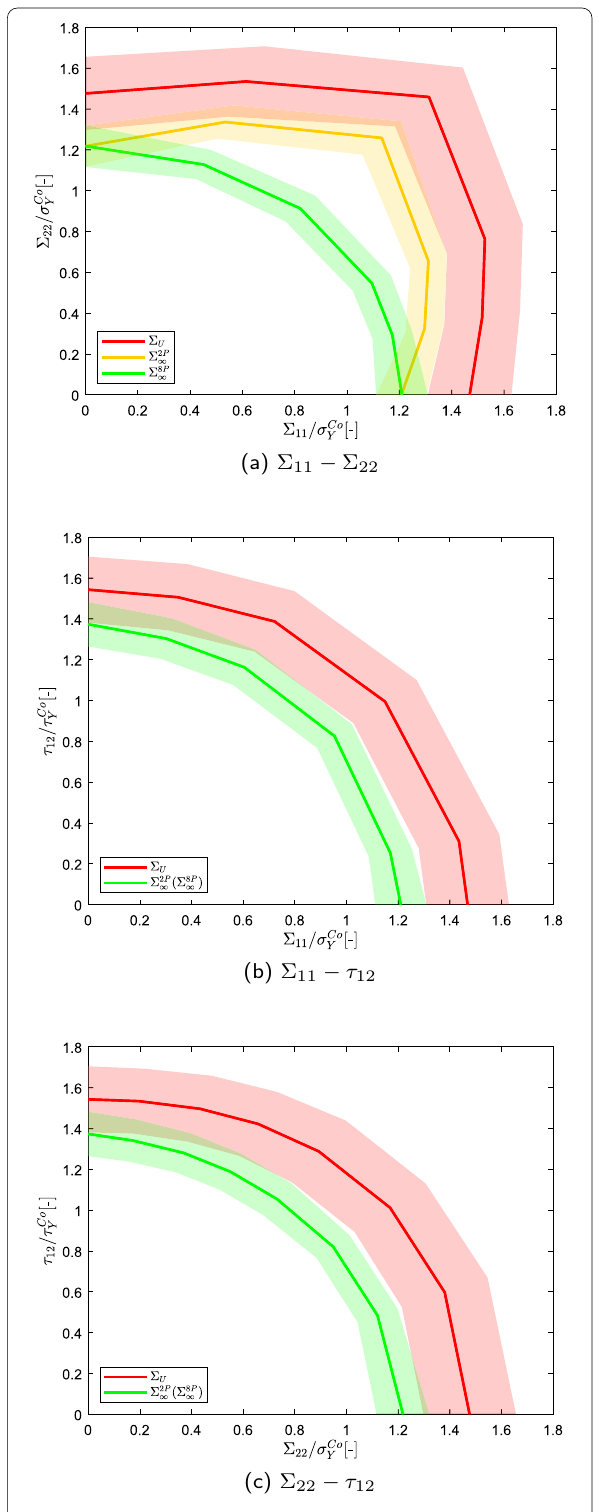
Figure 8 Projection of the load domain on three